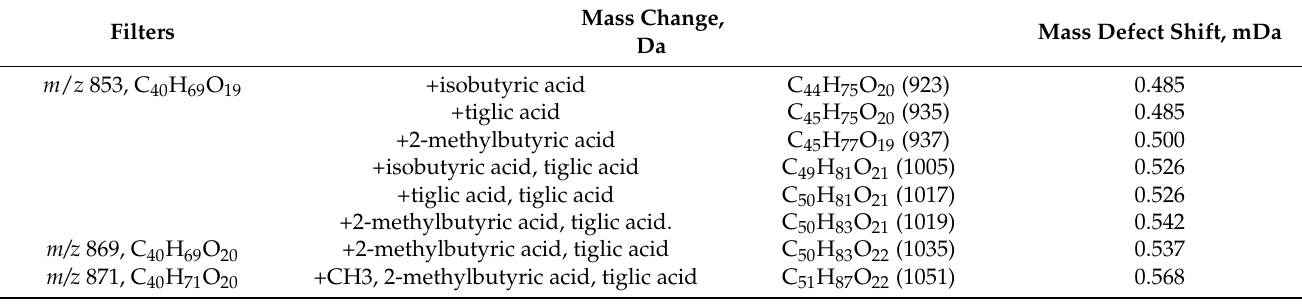
Table 3. Mass-range (Da)-mass defect(mDa) for known resin glycosides from Convolvulus scammonia .